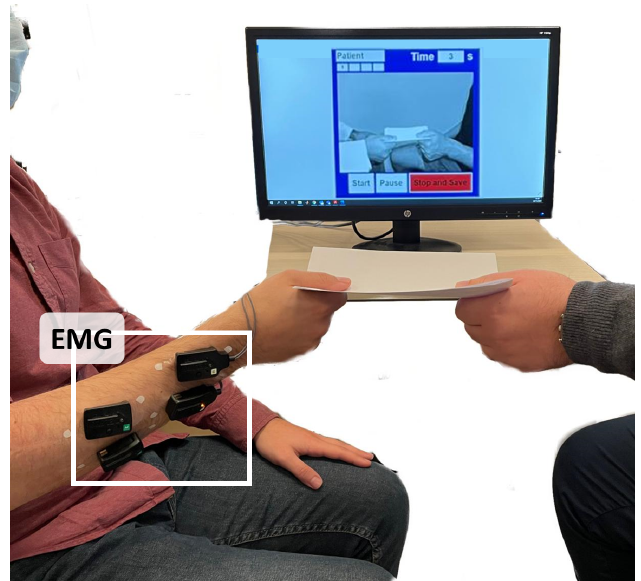
Figure 2. The experimental protocol for muscular synergies evaluation at the admission and discharge of the patient.